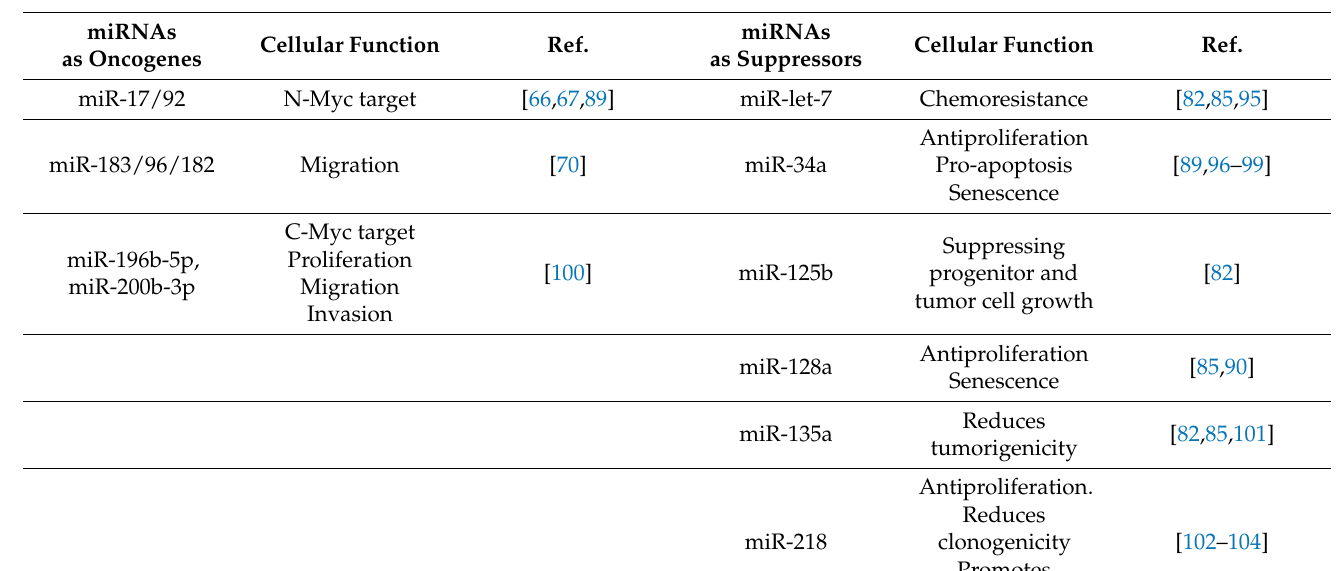
Table 1. Cont. SUBGROUP 2: SONIC